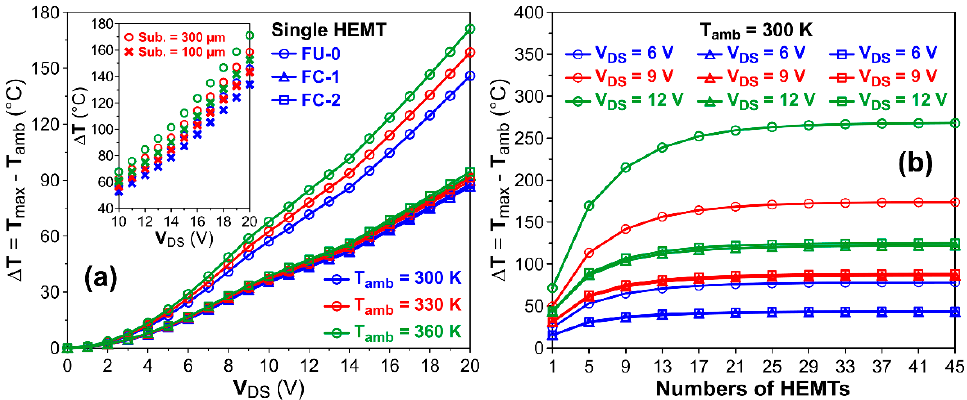
Figure 3. Calculated channel temperature rises for ( a ) single gate and ( b ) multiple gate GaN HEMTs. The channel temperature rises of FU-0, FC-1 and FC-2 are indicated by the circle, triangle and square, respectively. The blue, red and green lines plotted in Figure ( a ) indicate that the ambient temperatures are set to 300 K, 330 K and 360 K, respectively .